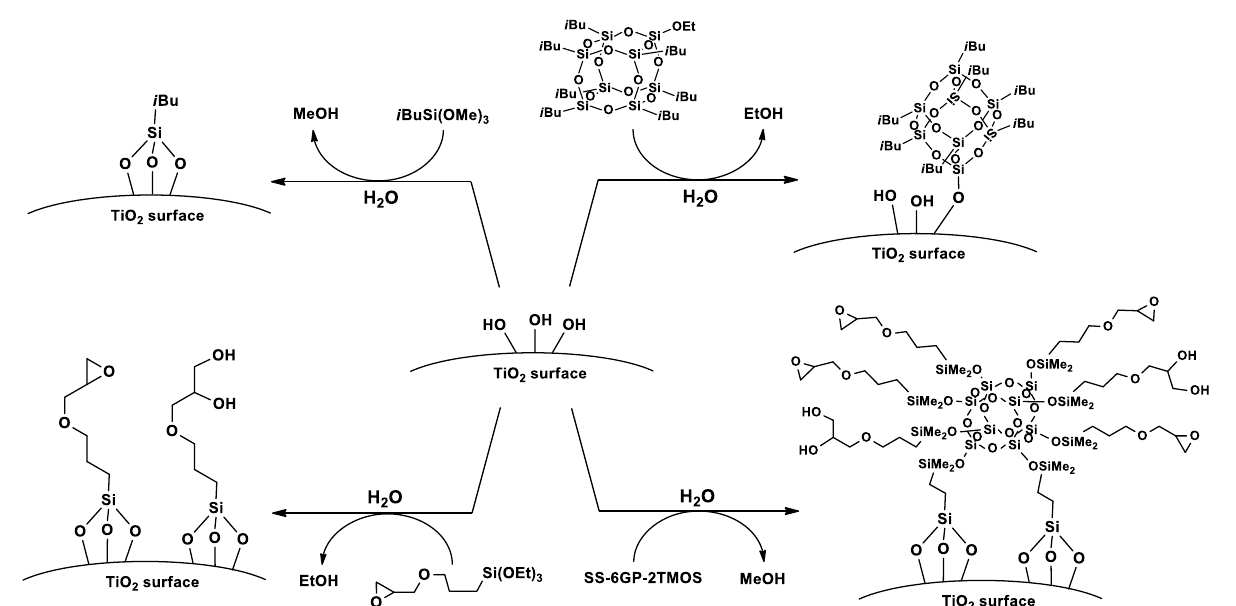
Figure 8. A proposed mechanism of TiO 2 surface silanization with i Bu 7 SSQ-OEt, SS-6GP-2TMOS and silane coupling agents.